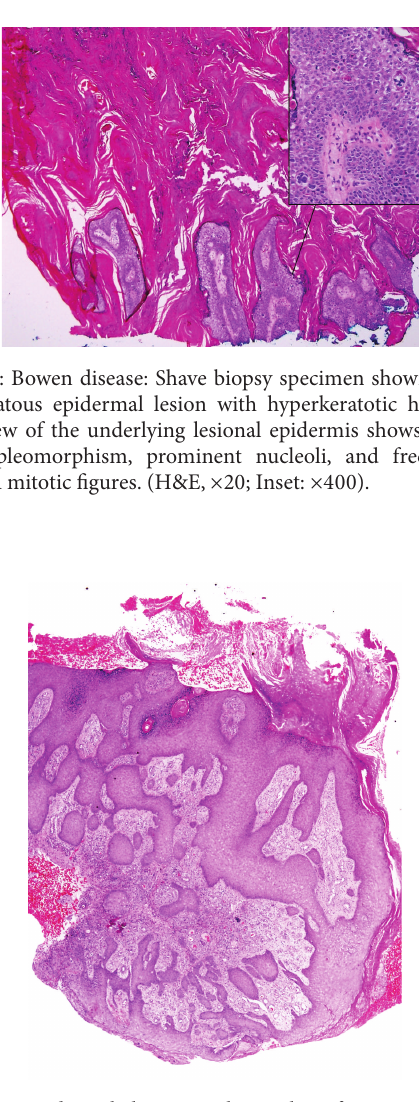
Figure 4: Pseudoepitheliomatous hyperplasia featuring acanthotic squamous epithelium showing irregular thick finger-like down- growths into the underlying dermis. (H&E, × 20).